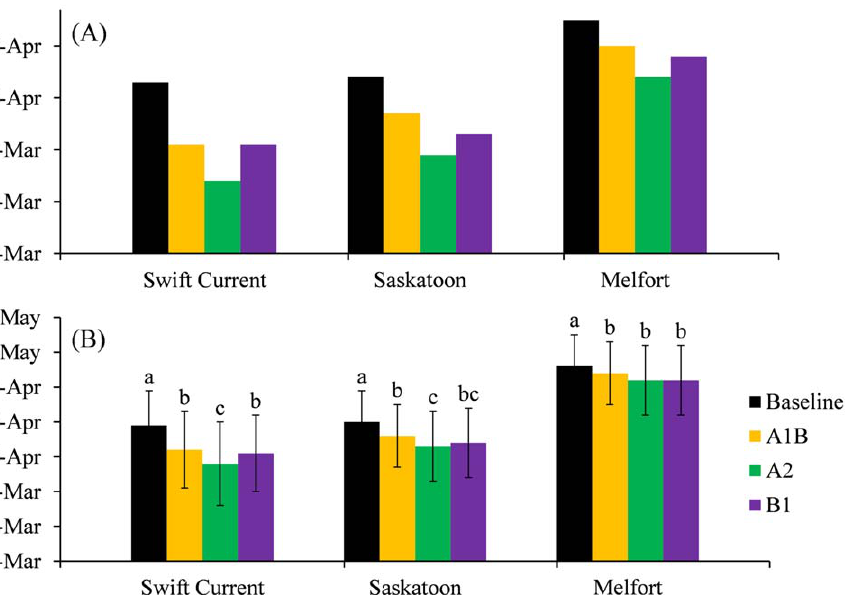
Figure 4. Initial modelling day of baseline and three scenarios for 2050s (A) and averaged seeding dates of baseline and three scenarios for 2050s (B). Within each site, values followed by the same letter are not significantly different at the 0.05 level of probability. Vertical bar indicate standard deviation (days).